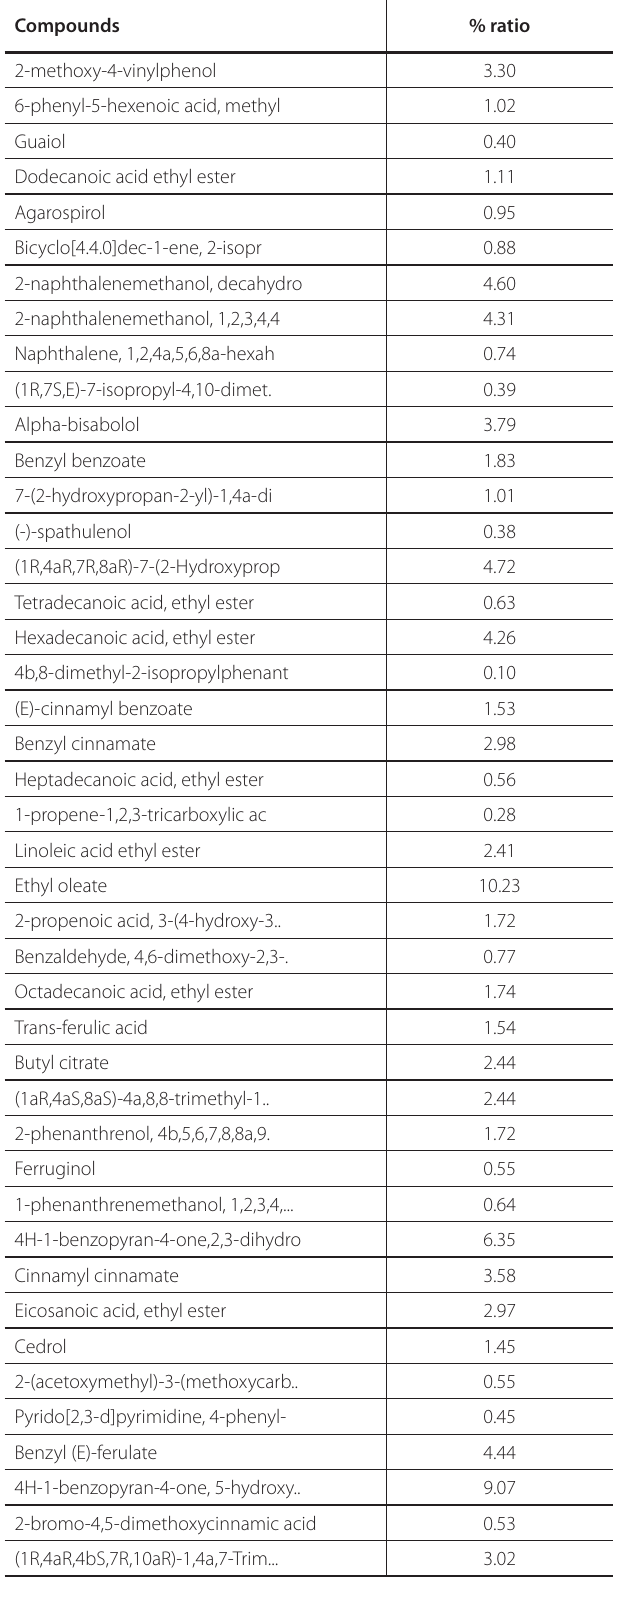
Table 2 . Spectrometry analysis of